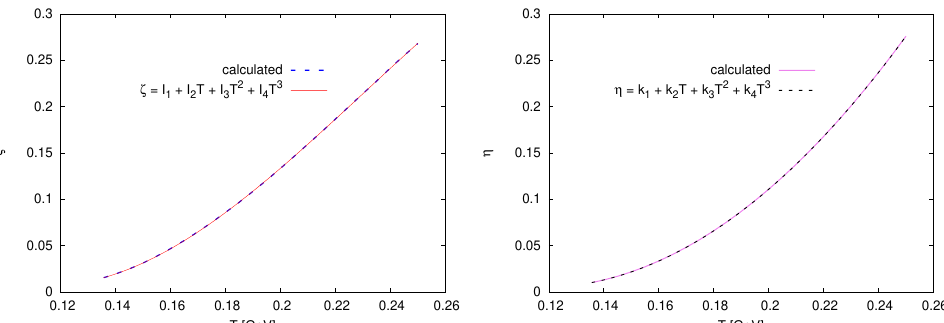
Figure 7. Left -hand panel depicts ζ as a function of T . Our calculations is shown as a solid curve, Equation (20), while the dashed curve is Equation (21). The right -hand panel gives η as a function of T . Our calculations is depicted as the solid curve, Equation (22), while the dashed curve shows results from Equation